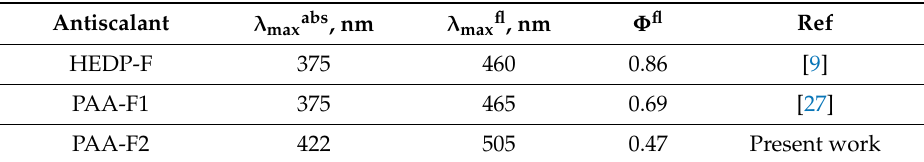
Figure 4. Excitation and emission spectra of PAA-F2 in H 2 O (0.39 mg · mL − 1 ) at 25 ◦ C. Table 1. Fluorescent efficiency of antiscalants.